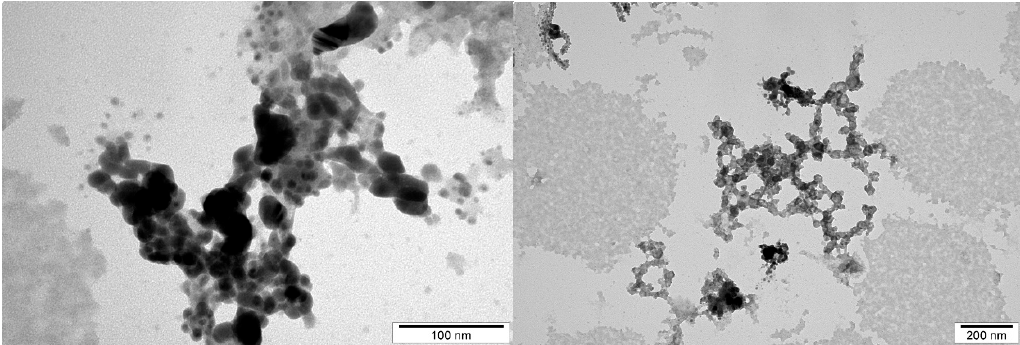
Figure 11. Transmission electron microscope photographs of